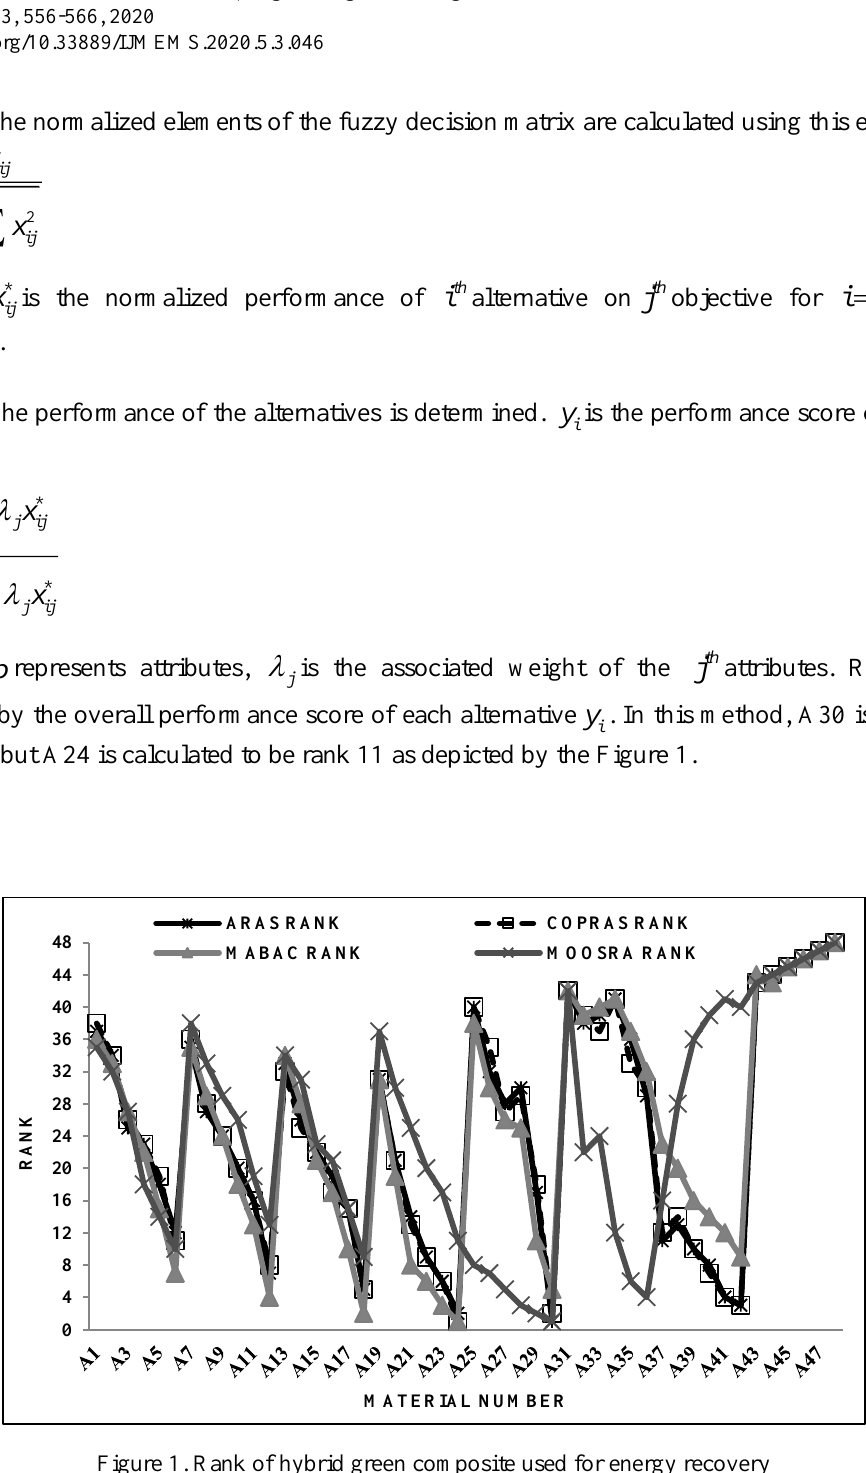
Figure 1. Rank of hybrid green composite used for energy